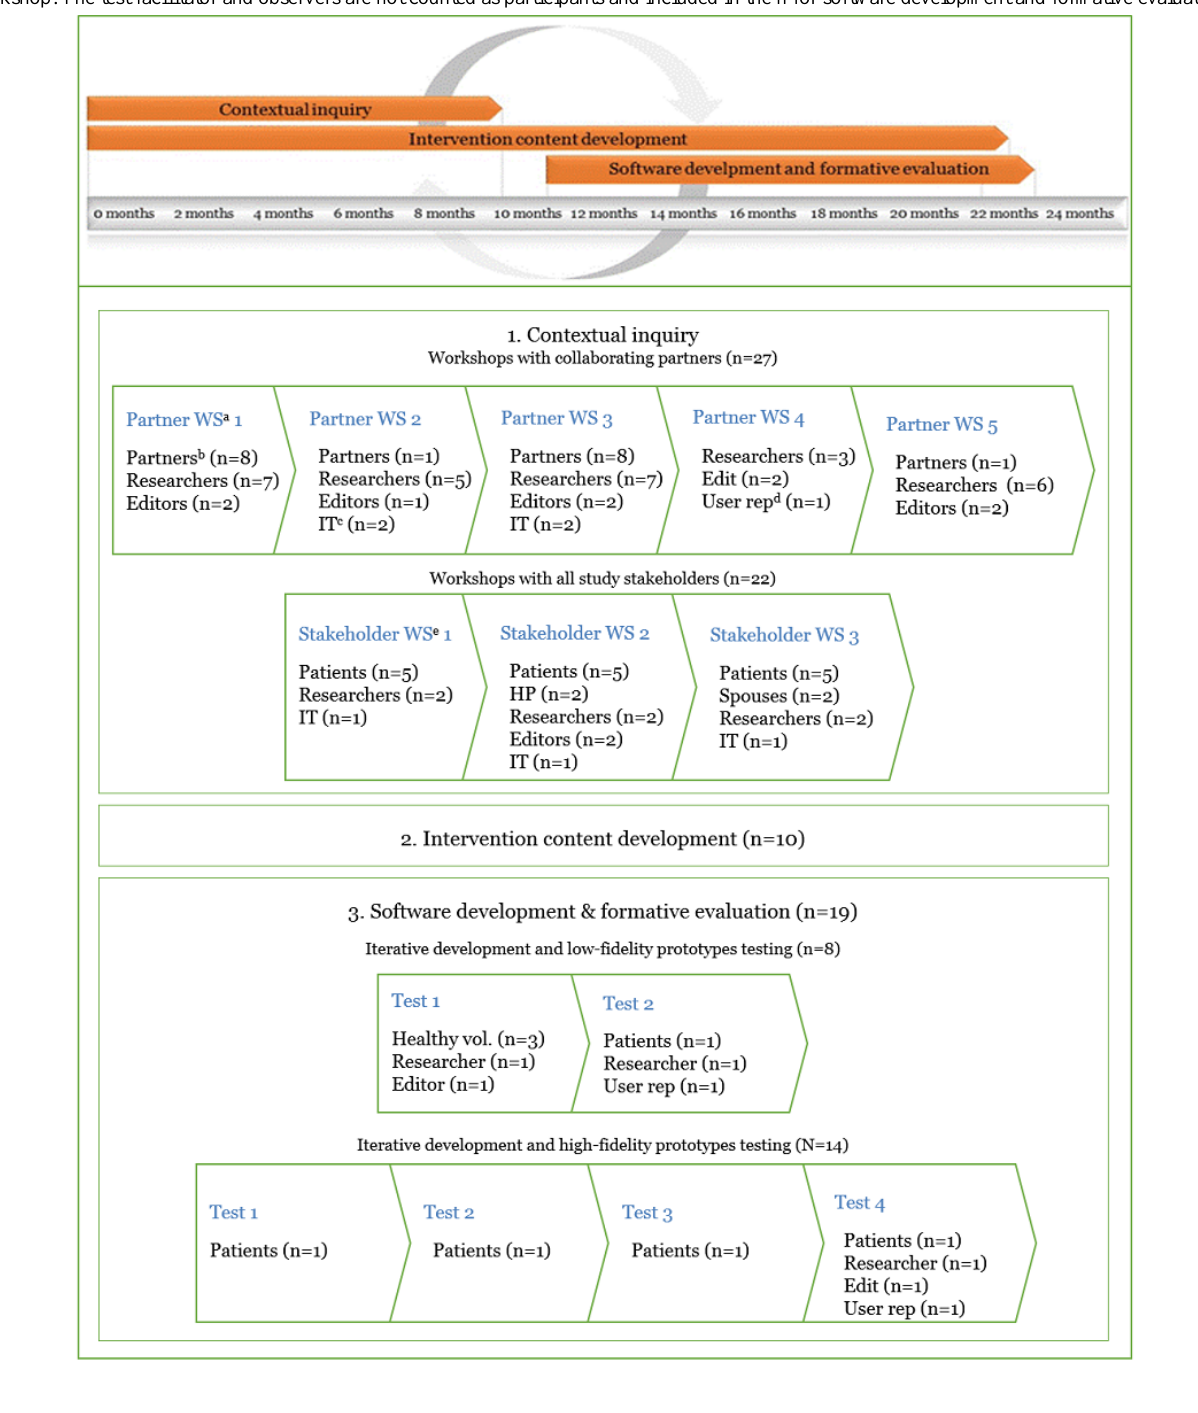
Figure 4. Overview of study timeline, intervention development process, activities, and participation. Partner WS: collaborating partners; Partners: collaborating partners; IT: person(s) from software team (ie, developers and designer); User rep: user representative; Stakeholder WS: stakeholder workshop. The test facilitator and observers are not counted as participants and included in the n for software development and formative